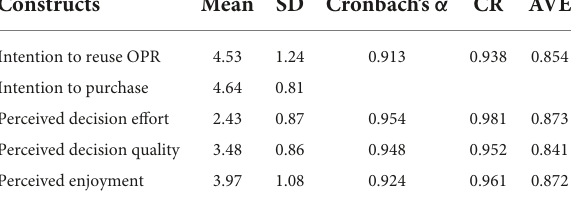
TABLE 6 Descriptive statistics and reliability